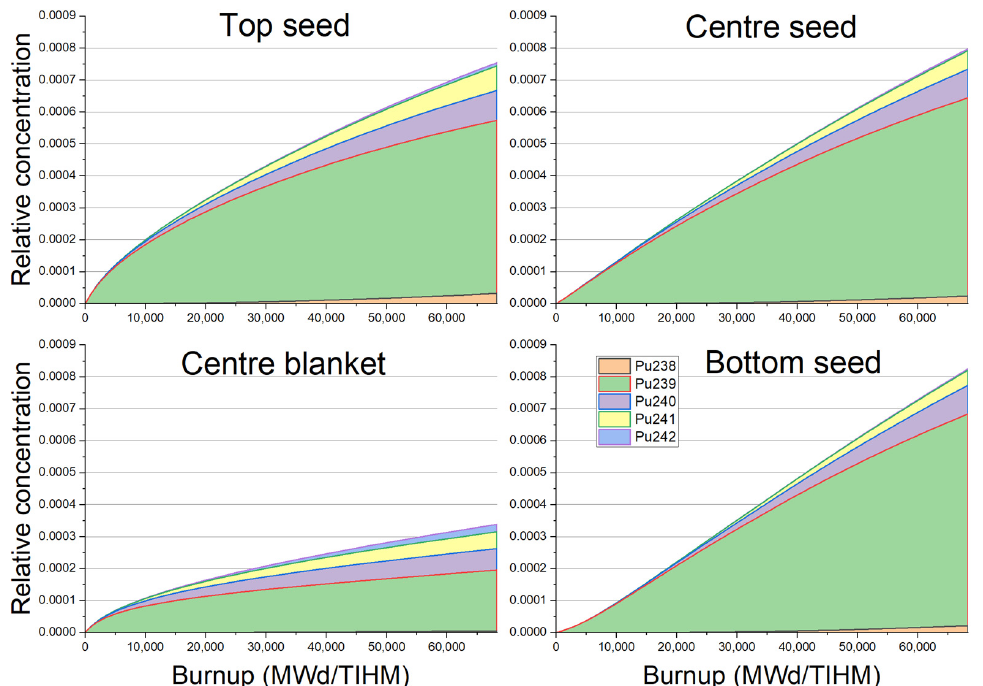
Figure 12. Concentrations of different plutonium isotopes throughout a burnup cycle, for a seed and blanket structured pin with regions of 100 cm size. The production of fissile plutonium (Pu-239 and Pu-241) in the top seed is faster at the start of the burnup cycle, in the region where the water density is lowest. The opposite is true for the bottom of the reactor pin. The central blanket region produces less plutonium than any seed region.